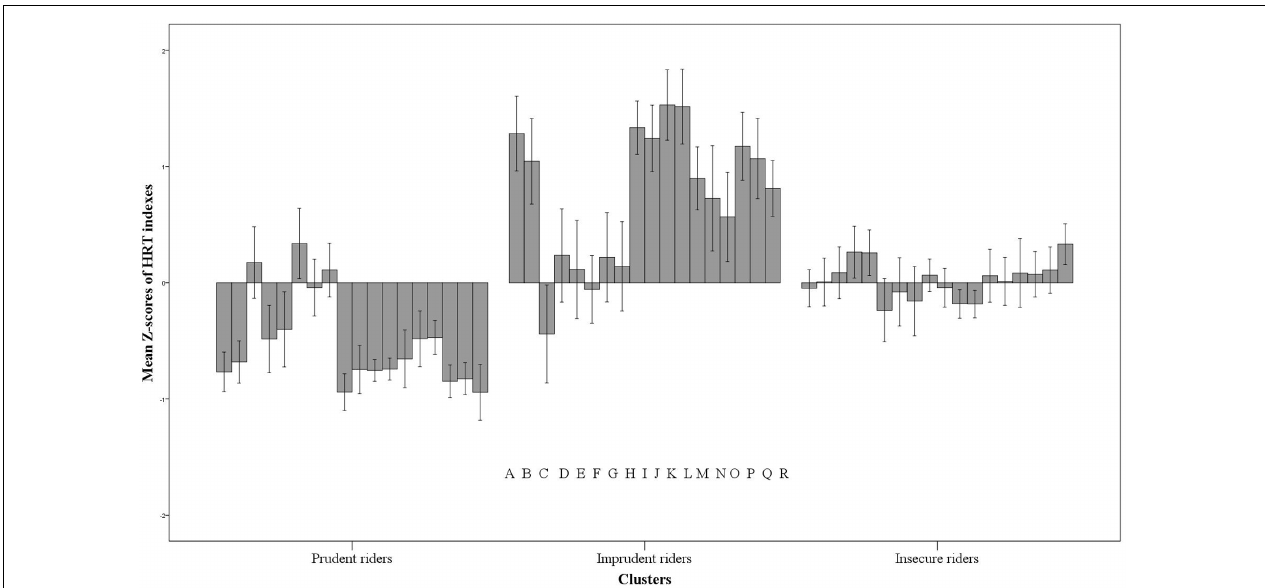
FIGURE 2 | Trends of the three clusters on the 18 HRT indexes. The indexes are reported for all three clusters in the order displayed by the letters on the bottom of the panel. The indexes are: Mean of the throttle opening (A) and its Standard deviation (B), Number of breakings with the front brake (C), Mean (D), and Standard deviation (E) of front brake pressure, Number of brakings with the rear brake (F), Mean (G), and Standard deviation (H) of rear brake pressure, Mean (I) and Standard deviation (J) of speed, Time spent over the speed limit (K), Number (L), Mean (M), and the highest value (N) of overspeeding, Mean (O) and Standard Deviation (P) of on-road instability, Number of accidents (Q) and Evaluation score (R). Vertical bars represent standard